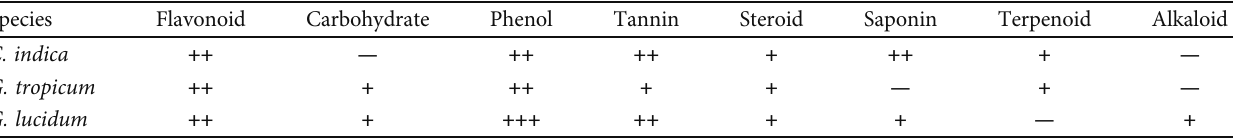
Table 1: Phytochemical analysis of the ethanolic extracts of the three mushroom species.